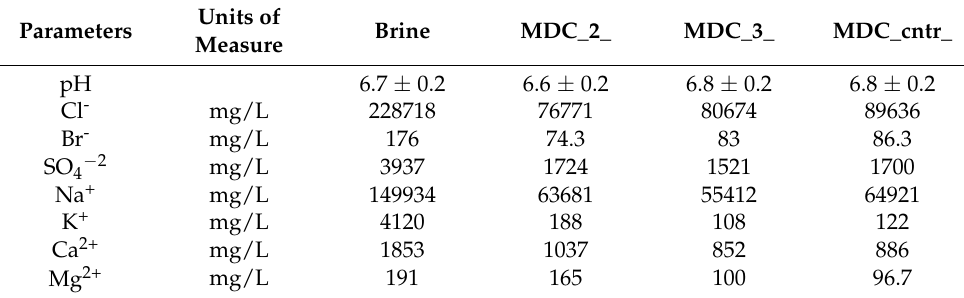
Table 2. Main salts’ content in brine before and after the treatment in